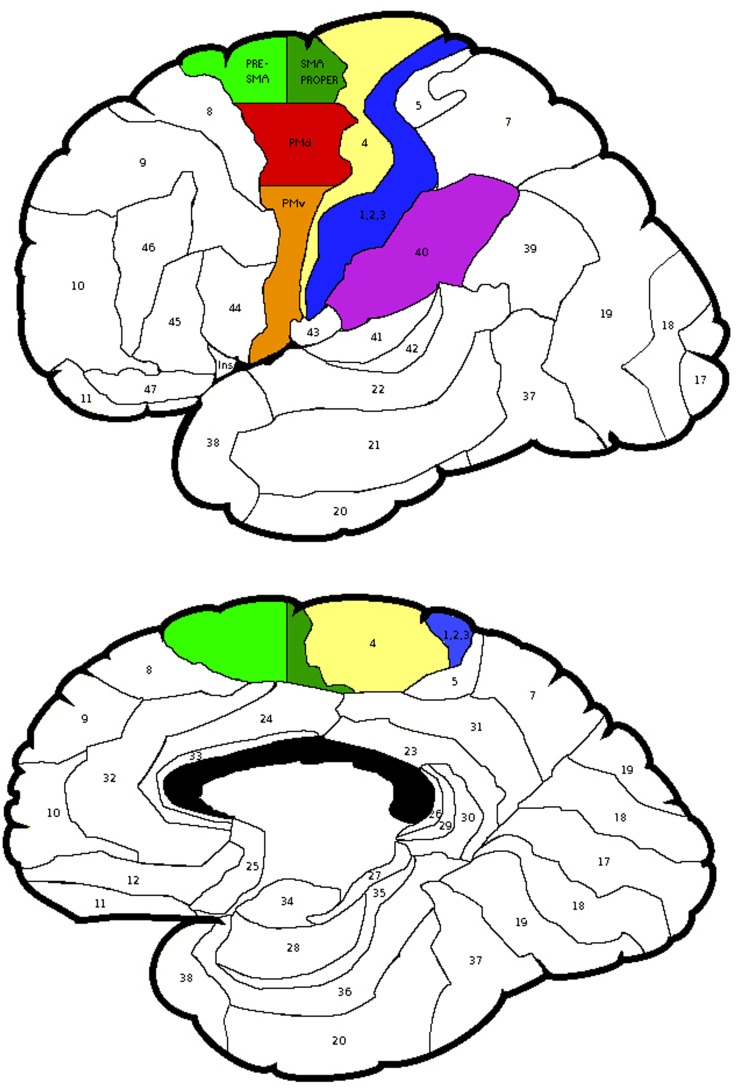
The regions of interest selected for the laterality calculations and the subdivisions of Brodmann Area 6. Areas depicted: Brodmann Areas 1,2,3, primary somatosensory cortex; area 4, primary motor cortex; area 40, supramarginal gyrus; PMv, ventral premotor cortex; PMd, dorsal premotor cortex; subdivisions of area 6, Pre-SMA, pre-supplementary motor area and SMA proper, supplementary motor area proper.